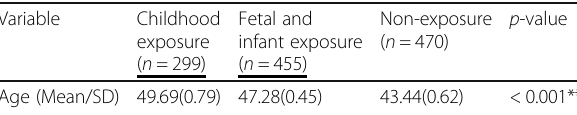
Table 2 Characteristics of the study participants,